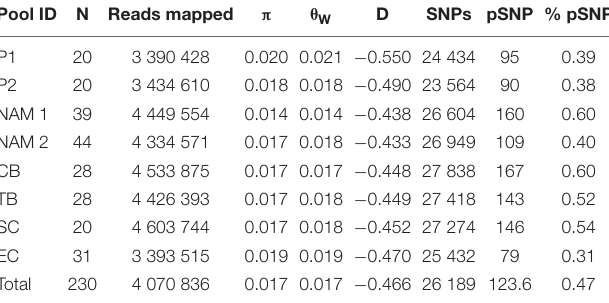
TABLE 2 | Regional diversity measures per pool for kingklip: N – number of individuals; π – nucleotide diversity (Tajima’s); θ W – population mutation rate (Watterson’s); D – Tajima’s index; SNPs – total number biallelic loci; pSNP – private biallelic SNPs, and% pSNP – percentage private biallelic